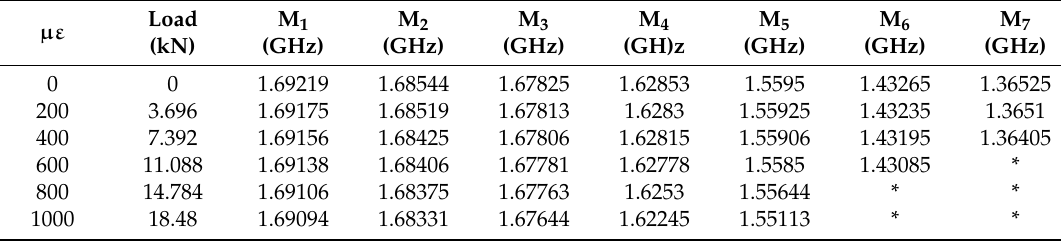
Table 7. Influence of strain on crack detection performance of antenna